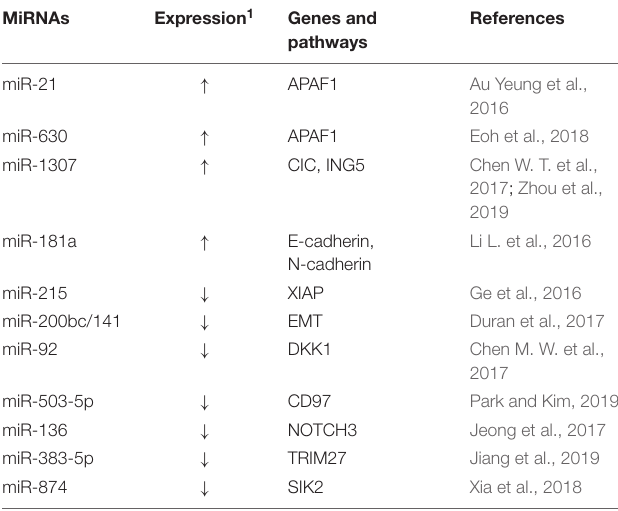
TABLE 2 | MiRNAs and paclitaxel resistance in ovarian